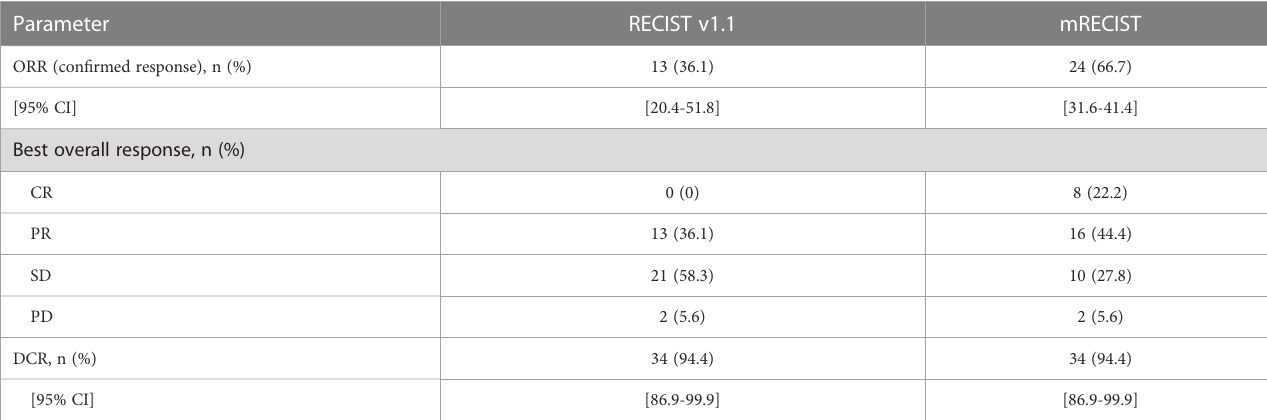
TABLE 3 Summary of Ef fi cacy